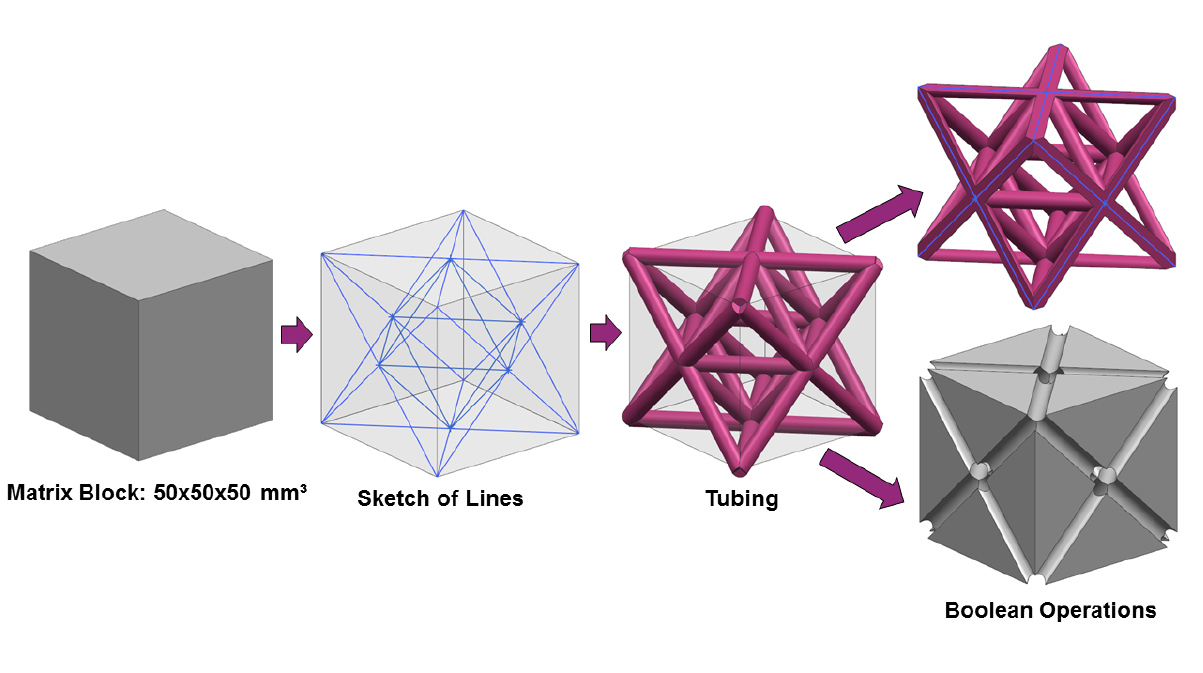
Figure 2. Modelling procedure represented by an Octet structure.